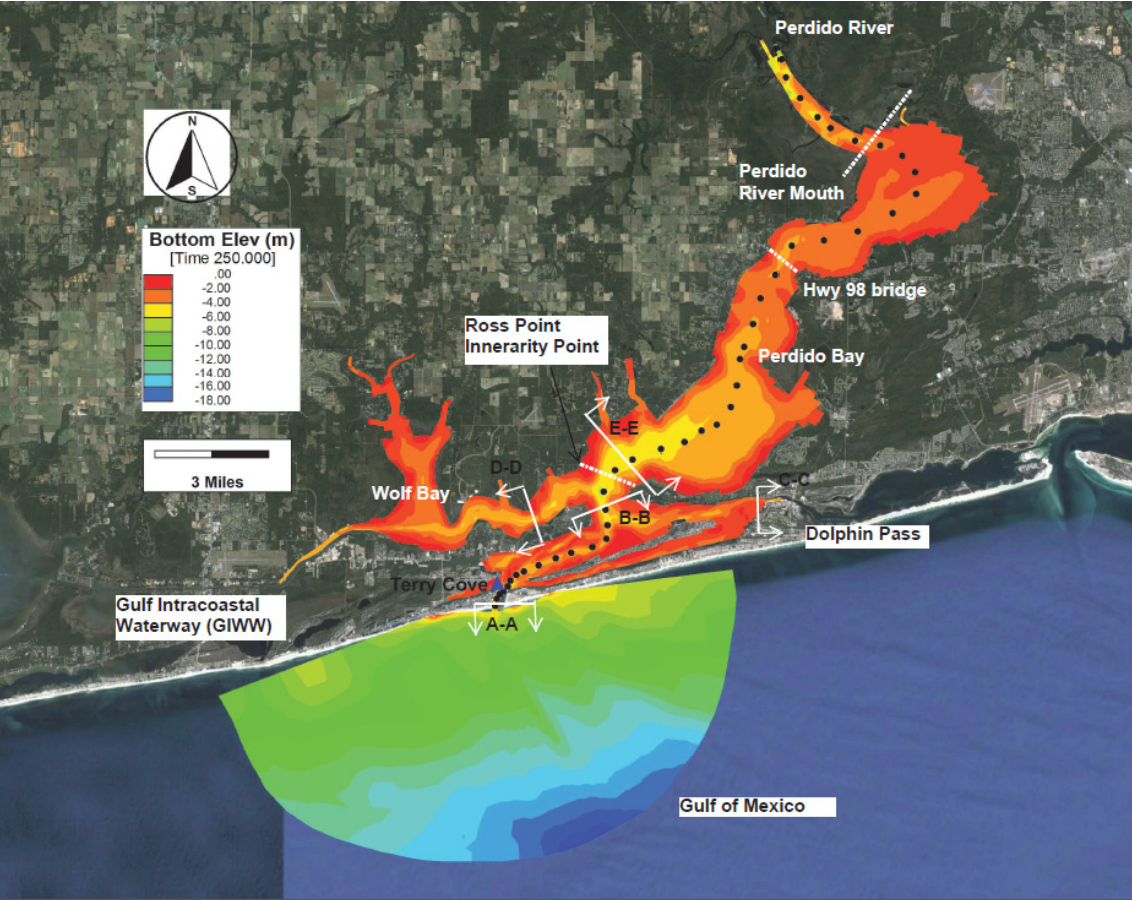
Figure 1. Environmental Fluid Dynamic Code (EFDC) model domain for Wolf Bay and Perdido Bay connected to the Gulf of Mexico through Perdido Pass, to eastern Big Lagoon through Dolphin Pass, and to western Mobile Bay through the Gulf Intracoastal Waterway (GIWW), showing the colored contours of bottom elevation and cross sections (A–A, B–B, C–C, D–D, and E–E) where water and salt fluxes were calculated. A centerline from Perdido Pass to Perdido River is represented using a series of dots for studying the salinity profile. White dashed lines refer to three cross sections used in Figure 3 and for discussion in the paper. Devkota et al . [19] developed and calibrated an EFDC model for the PBWB system to understand the age of water in the system under different inflows from the rivers flowing into Wolf Bay and Perdido Bay. The model was calibrated from 6 September 2008 (Julian Day 250) to 13 July 2009 (Julian Day 560 starting from 1 January 2008). The PBWB system is connected to the Gulf of Mexico via three open boundaries (Figure 1): Perdido Pass on the south, Dolphin Pass—Connected to Big Lagoon and eventually to Pensacola Bay—On the East, and the Gulf Intracoastal Waterway (GIWW—Connected to the Mobile Bay and eventually to the Gulf of Mexico—To the